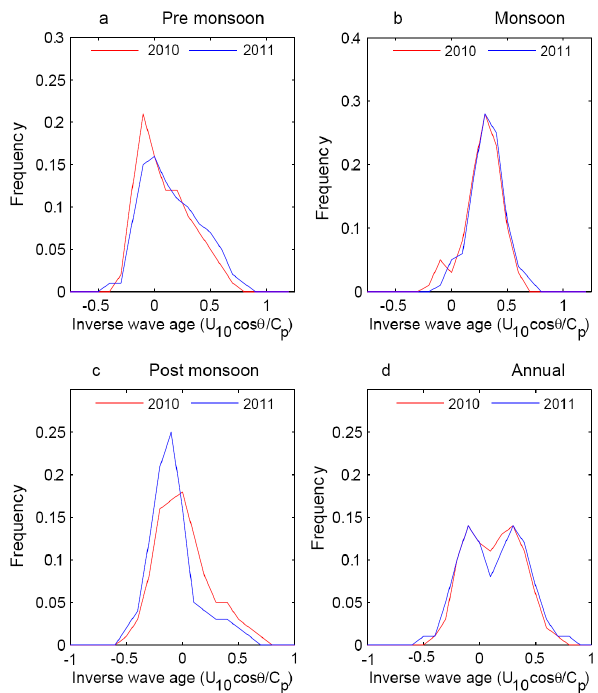
Fig. 5. Histogram of inverse wave age calculated based on observed Figure 5: Histogram of inverse wave age calculated based on observed wave direction and NCEP 484 wave direction and NCEP wind data at Ratnagiri during (a) premon- wind data at Ratnagiri during a) pre monsoon, b) monsoon, c) post monsoon and, d) annual 2010-485 soon, (b) monsoon, (c) postmonsoon and, (d) annual 2010–2012.